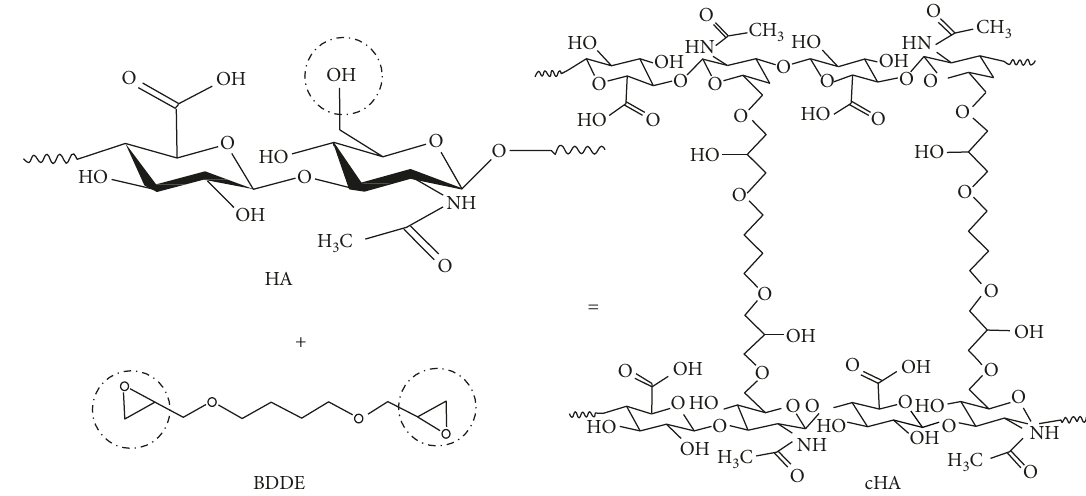
Figure 1: Chemical reaction equation for the preparation of CHA by BODE crosslinking